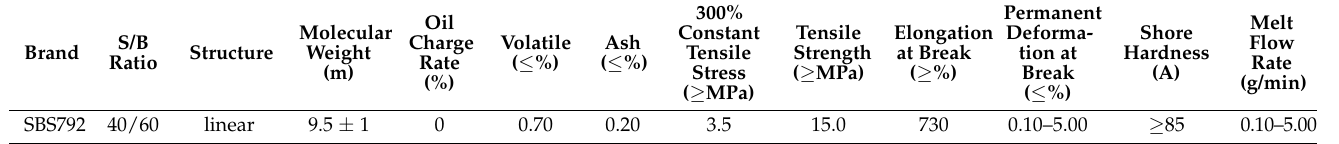
Table 3. Physical properties of SBS1401 (YH-792).